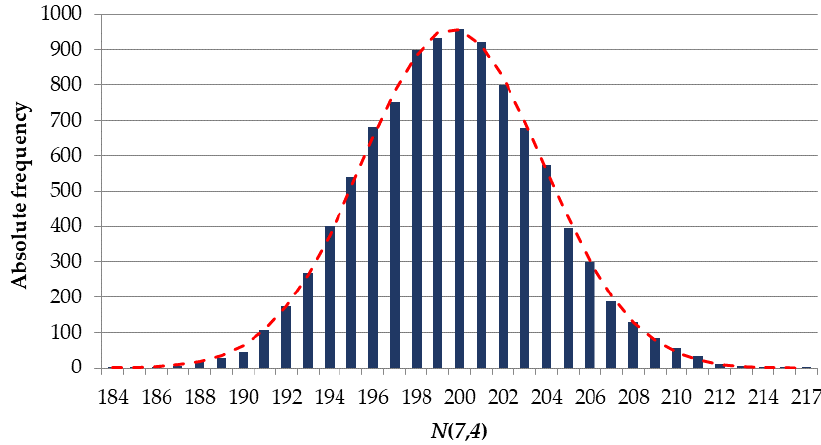
Figure 3. Histogram of the distribution of a random value N ( 7,4 )